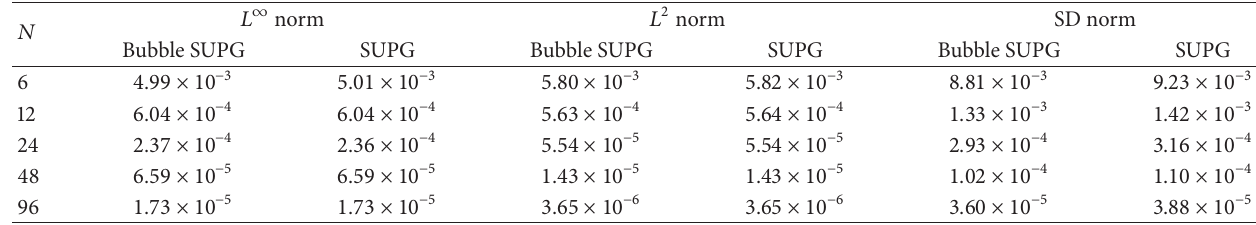
Table 6: 𝜀 = 10 −8 , Problem 2 (comparison of convergence